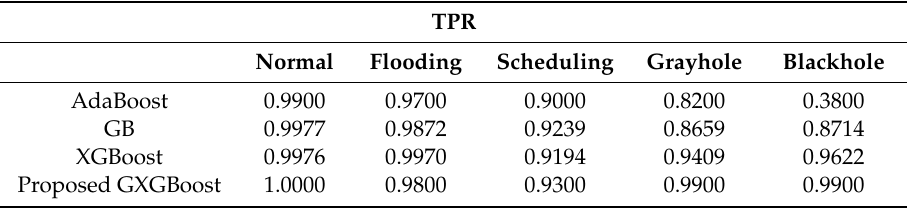
Table 11. Comparison results of TPR for GXGBoost against the original XGBoost and other boosting classifiers